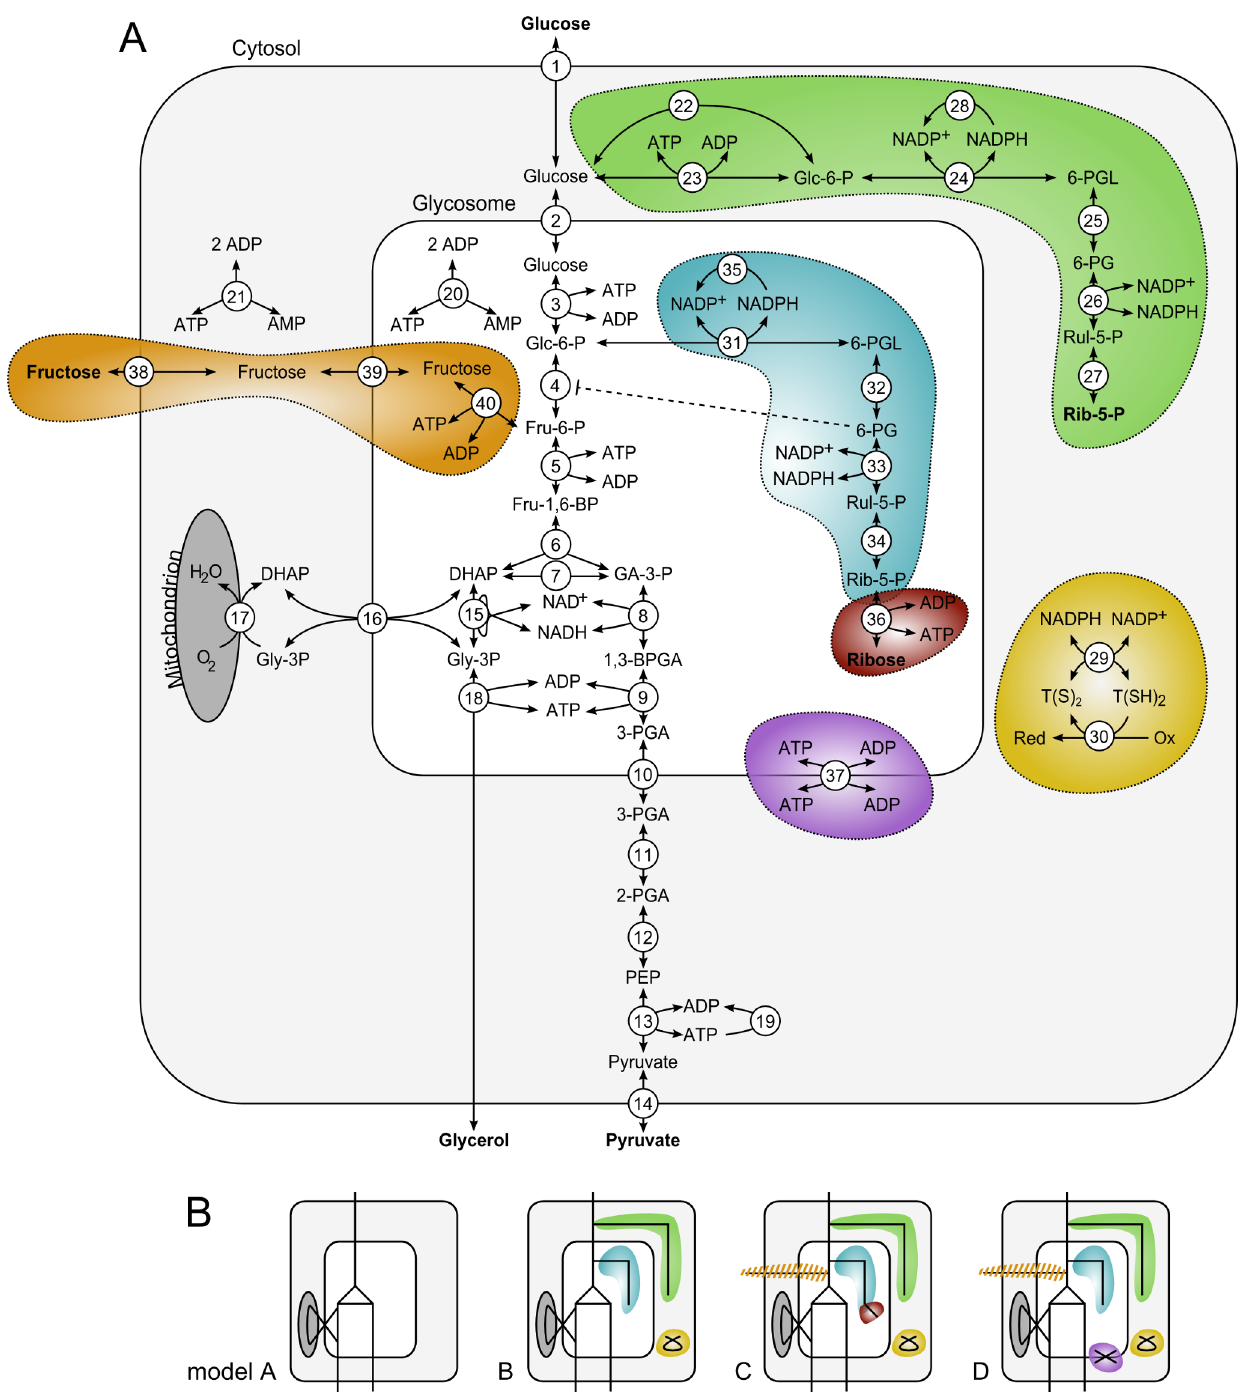
Figure 1. Schematic overview of the models used for simulation. ( A ) Detailed scheme of the modeled metabolic pathways. The numbered arrows correspond to reactions from Table 1. Extensions to the original model of glycolysis are indicated by colored shapes. Boundary metabolites are in bold, glycosomal Rib-5-P is a boundary metabolite in model C and D. ( B ) Schematic overview of the different models, each consisting of a unique combination of the colored modules described in ( A ) and Table 1. Model C and D can alternatively utilize fructose (model C fru and D fru ), but this branch is switched off unless specifically mentioned.